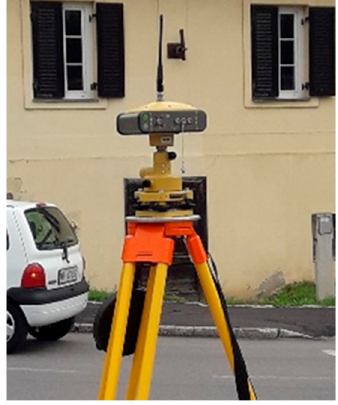
Figure 4. Base station Topcon Hyper Pro.